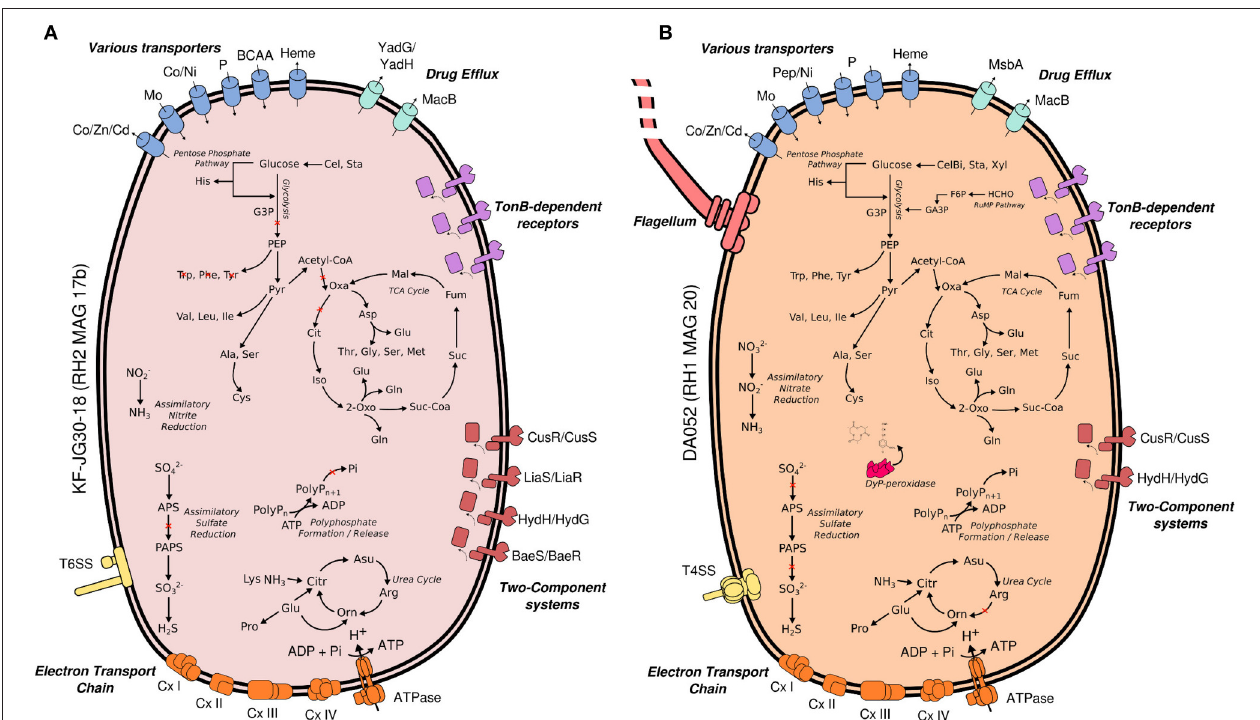
FIGURE 4 | Metabolic traits of KF-JG30-18 (A) and DA052 (B) as derived from the genetic potential of RH2 MAG 17b and RH1 MAG20. Functional annotations are based on PROKKA (Seemann, 2014) and RAST (Aziz et al., 2008; Overbeek et al., 2014). Both annotation results were thoroughly validated against each other. Pathways were reconstructed by UBLAST ( Edgar, 2010) searches of predicted coding genes against NCBI nr. Predicted genes were additionally classified against the KEGG reference database using KEGGMAPPER. Red crosses indicate missing genes in the respective pathways. Co/Zn/Cd (cobalt/zinc/cadmium), Czc efflux pumps; Mo, molybdate; Ni, nickel; BCAA, branched-chain amino acids; YadG/YadH, uncharacterized ABC transporter; MsbA + MdlB, multi-drug resistant ABC transporter; MacB + YddA, macrolide-binding ABC transporter; CusS/CusR, two-component system sensing extracellular copper; HydH/HydG, two-component system sensing extracellular metal ions; LiaS/LiaR, two-component system sensing cell envelope stress; BaeS/BaeR, two-component system involved in antibiotic sensing; TXSS, type X secretion system; CxI-IV, complex I to IV of the respiratory chain; G3P, glycerate 3-phosphate; PEP, phosphoenolpyruvate; Citr, citrulline; Orn, ornithine; PolyP, polyphosphate; Oxa, oxaloacetate; Mal, malate; Fum, fumarate; Suc, succinate; Suc-CoA, succinyl-CoA; 2 Oxo, 2-oxoglutarate; Iso, isocitrate; Cit, citrate; APS, adenosine phosphosulfate; PAPS, phosphoadenosine phosphosulfate; Cel, cellulose; CelB, cellubiose; Sta, starch; Xyl, xylan; F6P, fructose 6-Phosphate; GA3P, glyceroaldehyde 3-phosphate; G3P, glycerol-3-phosphate; RuMP, ribulose monophosphate pathway; Dyp, dye-decolorizing